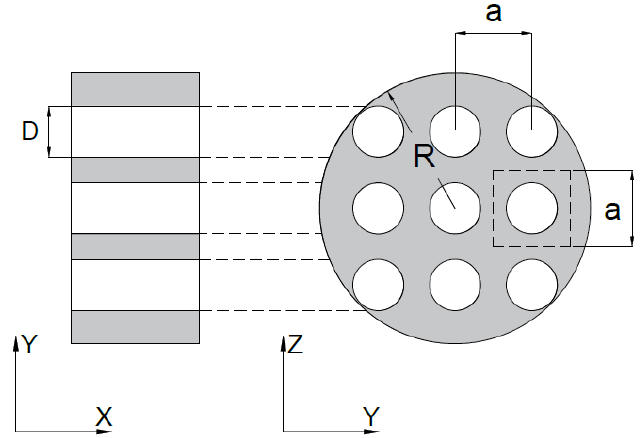
Figure 5. General configuration of 2D periodic perforated samples arranged in a square lattice with lattice constant a. D is denoted as the diameter of the perforated hole and R is the radius of the foam sample.